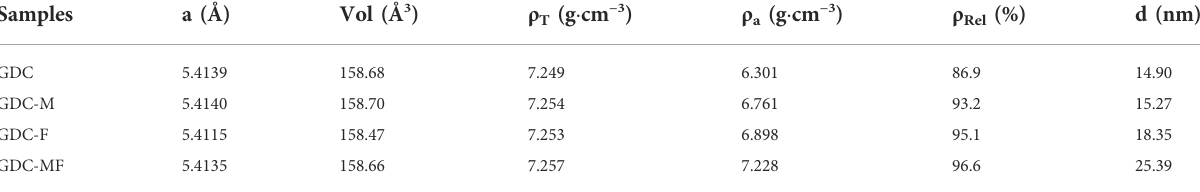
TABLE 1 Relevant parameters of GDC-based electrolytes sintered at 1200 ° C for 10 h.